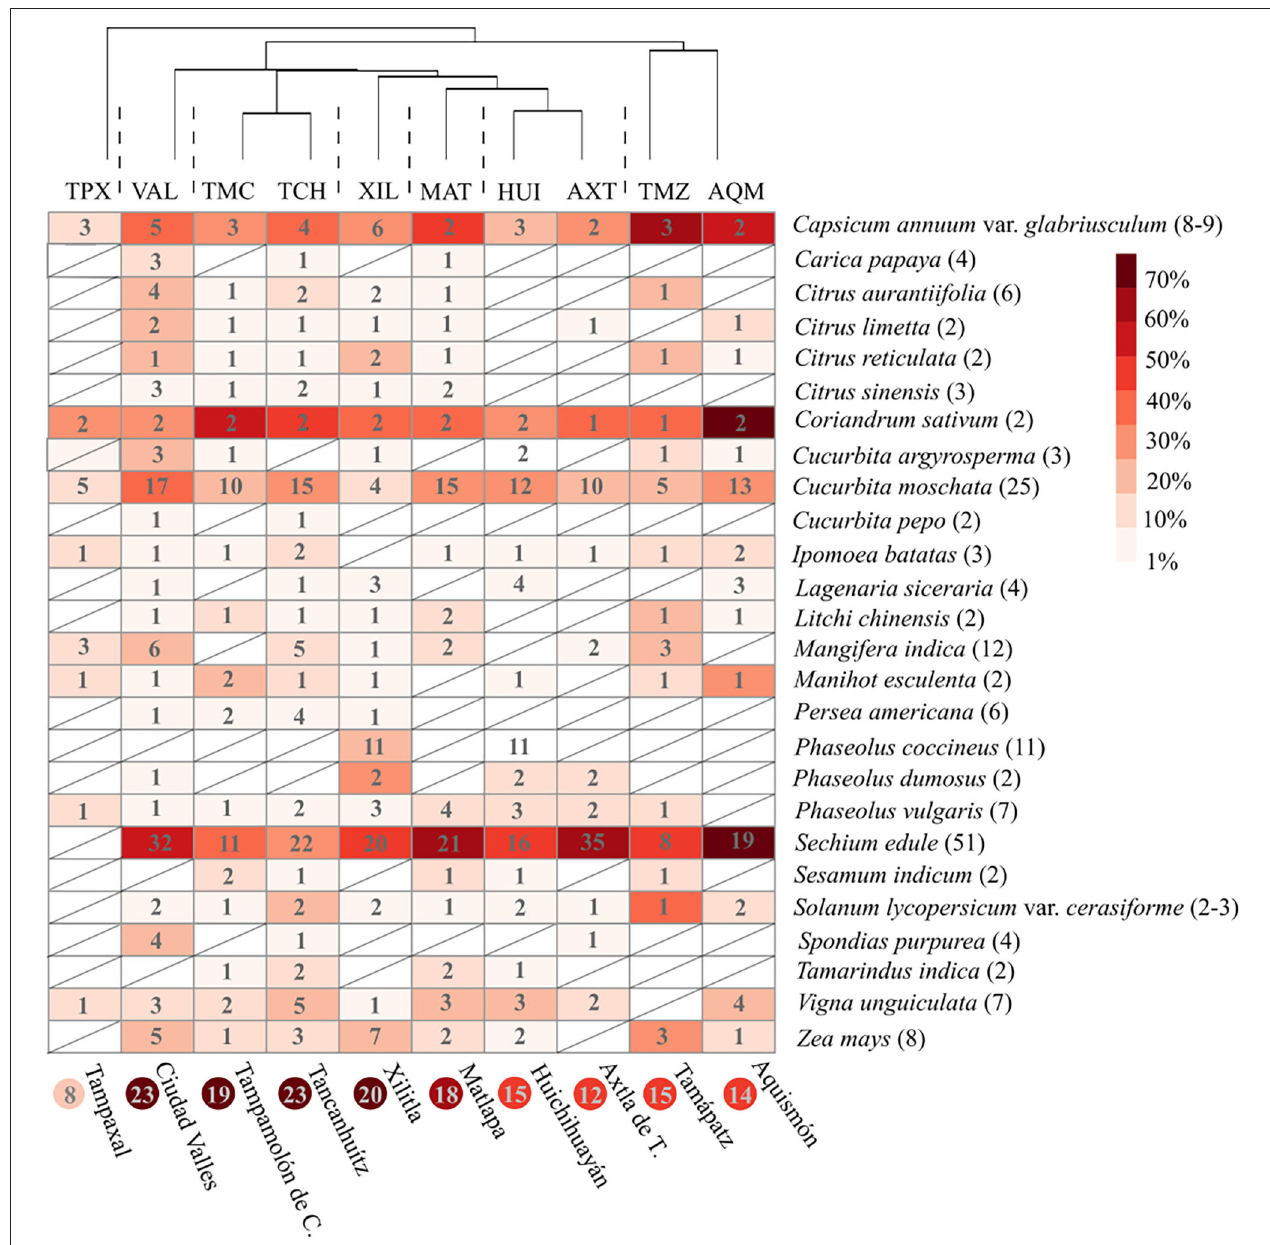
FIGURE 7 | Heatmap cluster displaying the proportion of local merchants in 10 local markets of the Huasteca Potosina who offer species with intraspecific diversity that are used as propagation material. Clustering heat maps were created using Ward’s method algorithm and Euclidean distance measure. The dashed lines separate the end groups. The intensity of the red fillings according to the scale shows the proportional abundance. The number in the quadrants represents the number of total variants of the listed species at each market, and the number in brackets the total number of variants in the 10 markets. The numbers below the diagram refer to the total number of species with intraspecific diversity and propagation potential in each market.